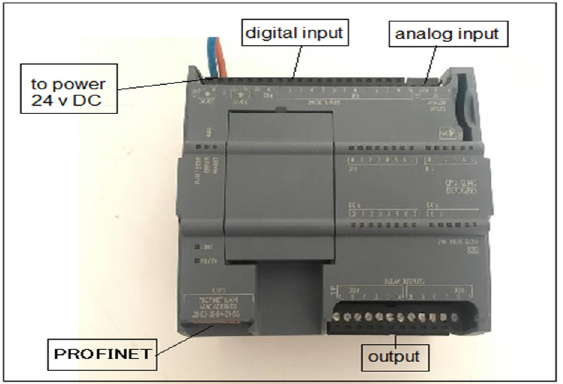
Fig. 7. S7-1200 PLC